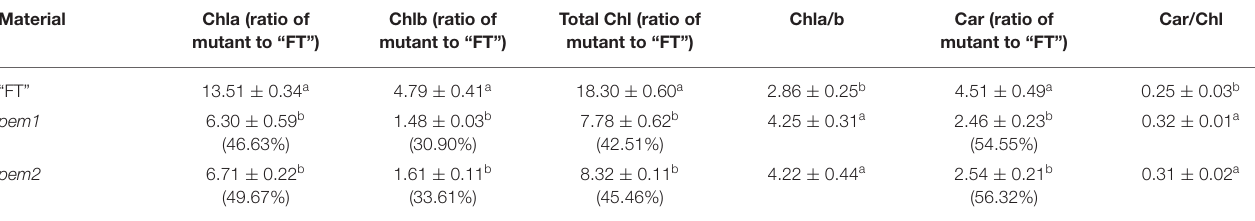
TABLE 1 | Content of photosynthetic pigments in pem1 and pem2 compared with wild-type “FT” (mgg-1). Material Chla (ratio of mutant to